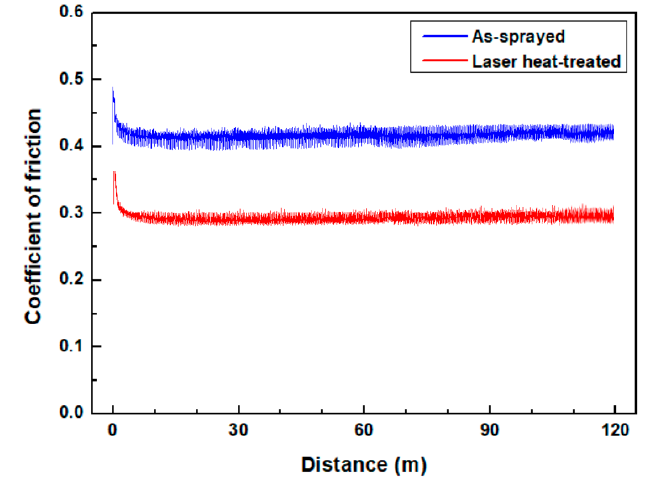
Figure 13. COF as a function of wear distance for the as-sprayed coating and laser heat-treated coating at 1473 K.